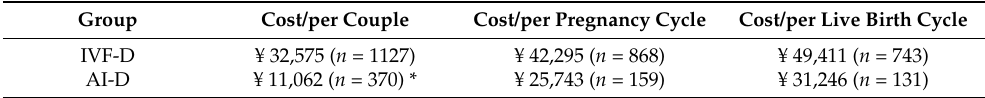
Table 3. Cost-effectiveness of IVF-D and